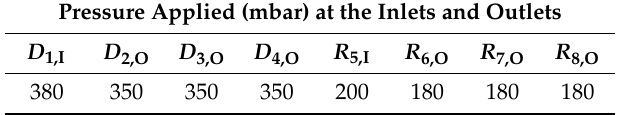
Table 1. Pressure settings at inlets and outlets of the microchip for growth experiments in capture and growth mode.